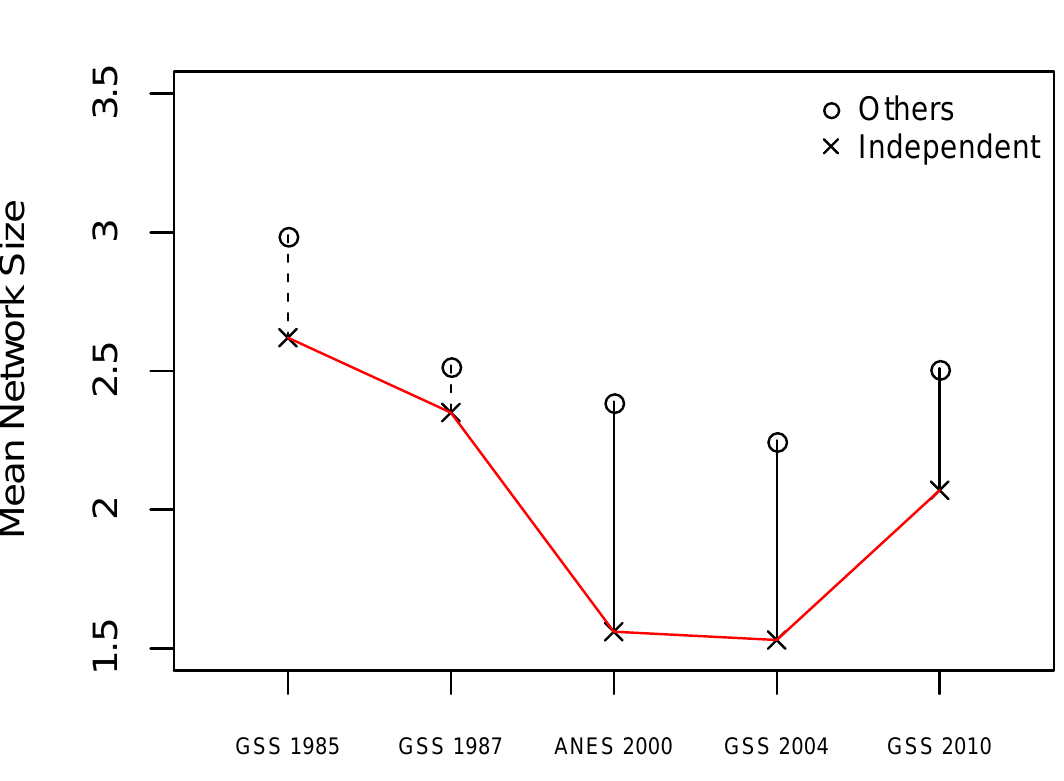
Figure 2: Differences of mean network size by party identification across sample surveys. Note: Each X represents the average network size among those who identify themselves as independent on the party identification scale, and each circle represents estimates among other members excluding the independent category. Statistically significant differences between the two are plotted as a solid line, otherwise as a dotted